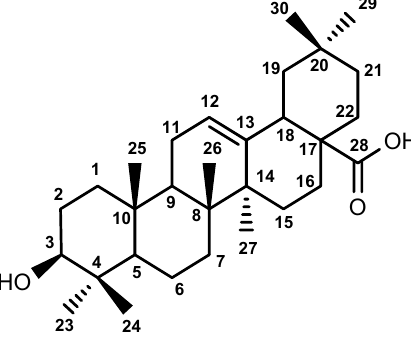
Figure 1. Structure of oleanolic acid.